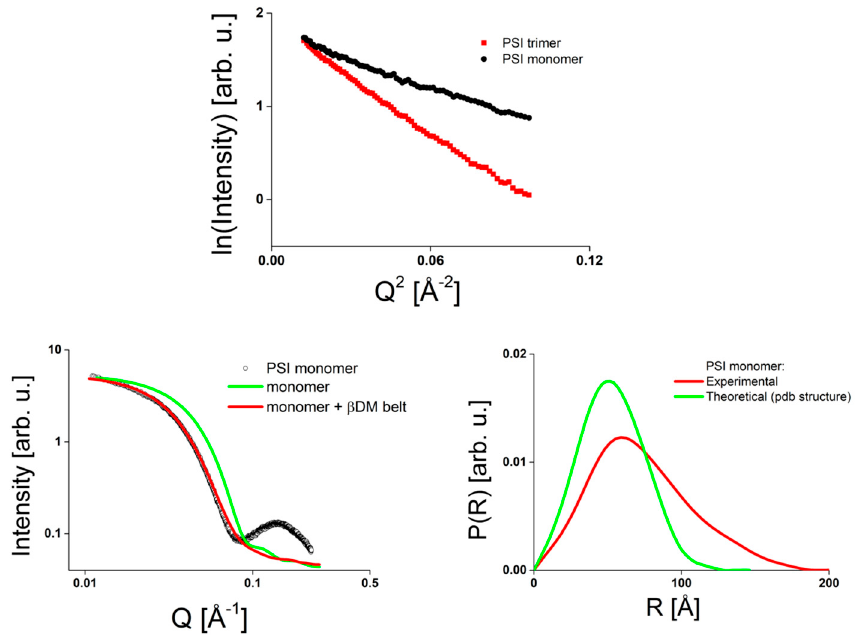
Figure 2. Photosystem I (PSI) SAXS data in comparison to the crystal structure: ( Upper ) Panel: SAXS curves of solubilized PSI in monomeric (black) and trimeric form (red) shown as Guinier plots at small q values. ( Lower Left ) Panel: Experimental SAXS curves (black dots) with fits based on the crystal structure of monomeric PSI only (green) and assuming a detergent belt around PSI (red). ( Lower Right ) Panel: Normalized pair distance distribution (P(r)) functions derived from the experimental SAXS data (red) and from the PSI crystal structures (green) by inverse Fourier transform. Graphics taken from Golub et al., 2017 [62] with permission.